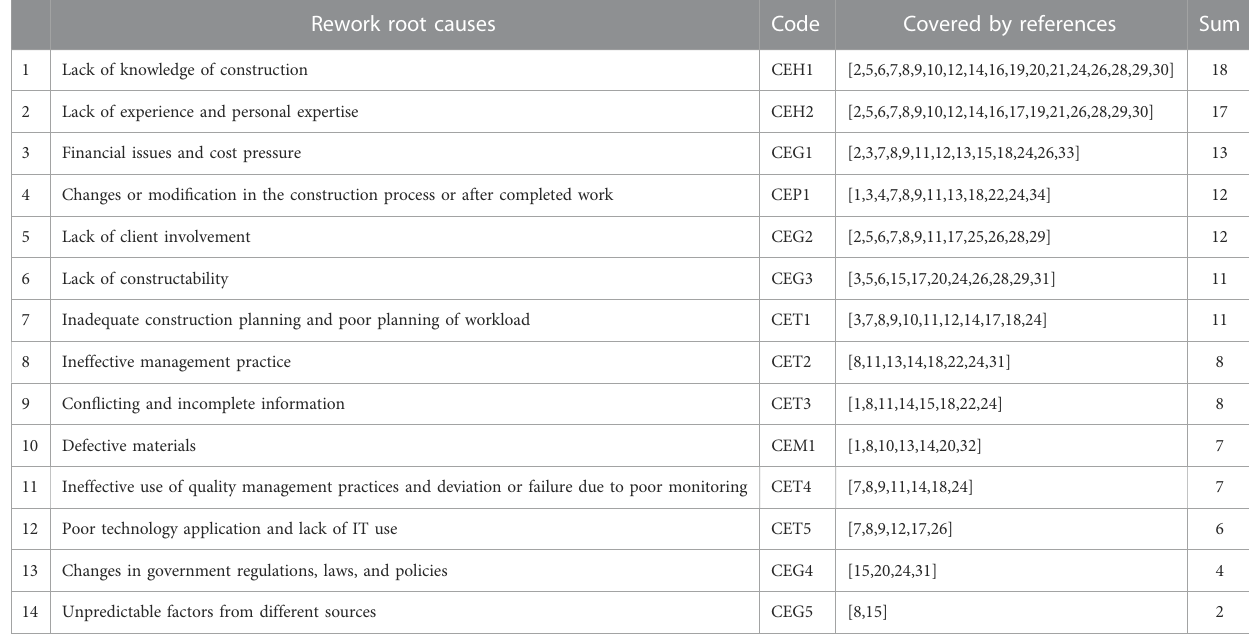
TABLE 6 Rework causes classi fi cation in construction stage — liable to the client-side of the contract. Rework root causes